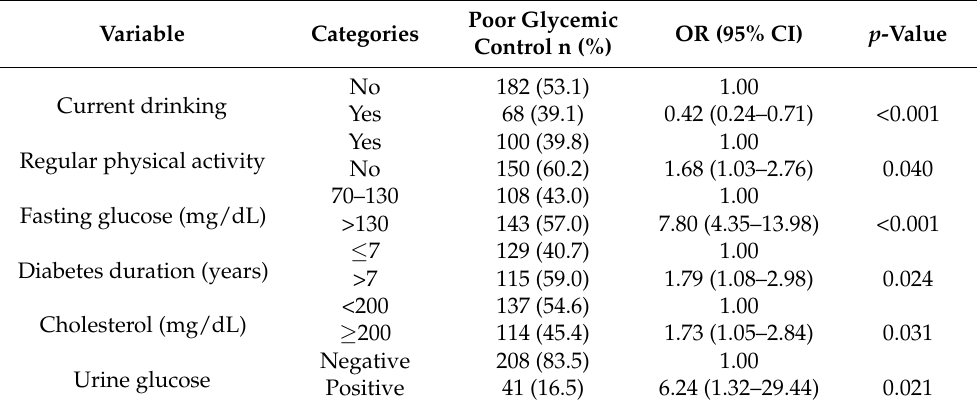
Table 2. Factors associated with poor glycemic